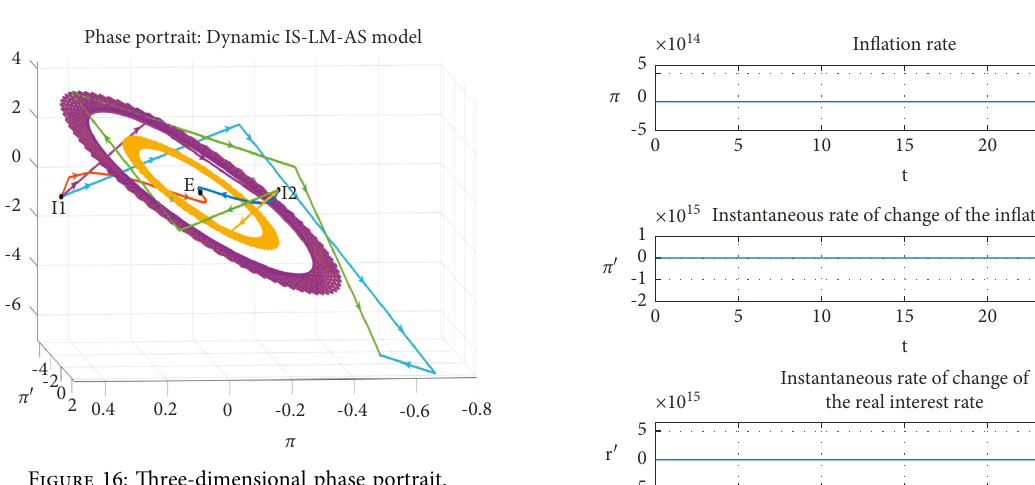
Figure 15: Time paths of the interest rate, real GDP, inflation, expected inflation, and instantaneous rates of change of interest rate and 10). inflation (case β β 0 (cid:31) (cid:31)